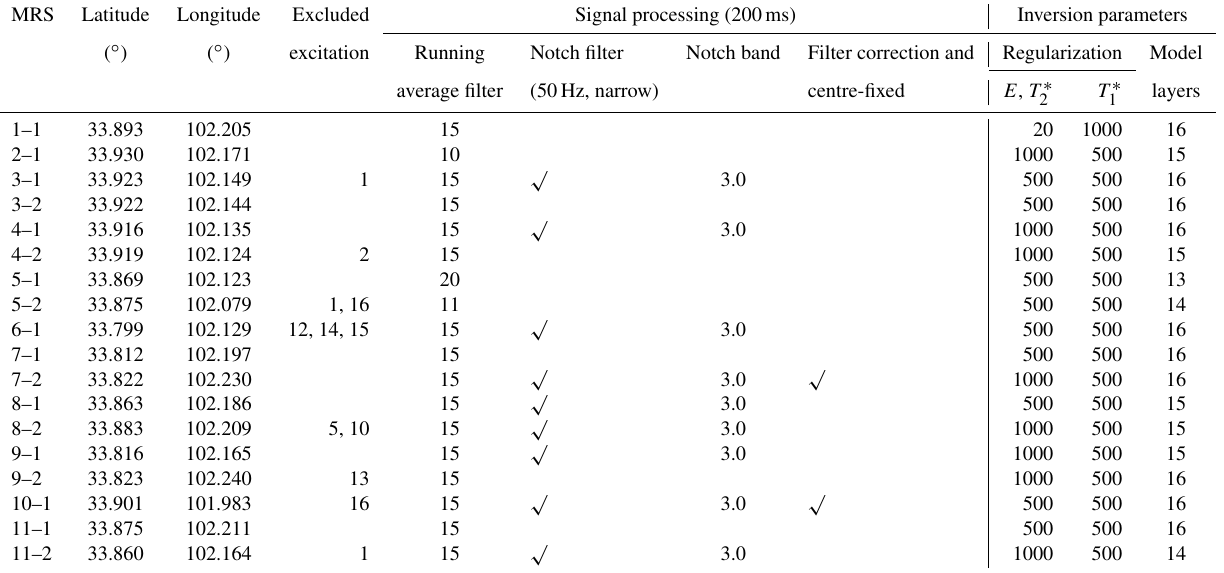
Table A7. Inversion parameters for